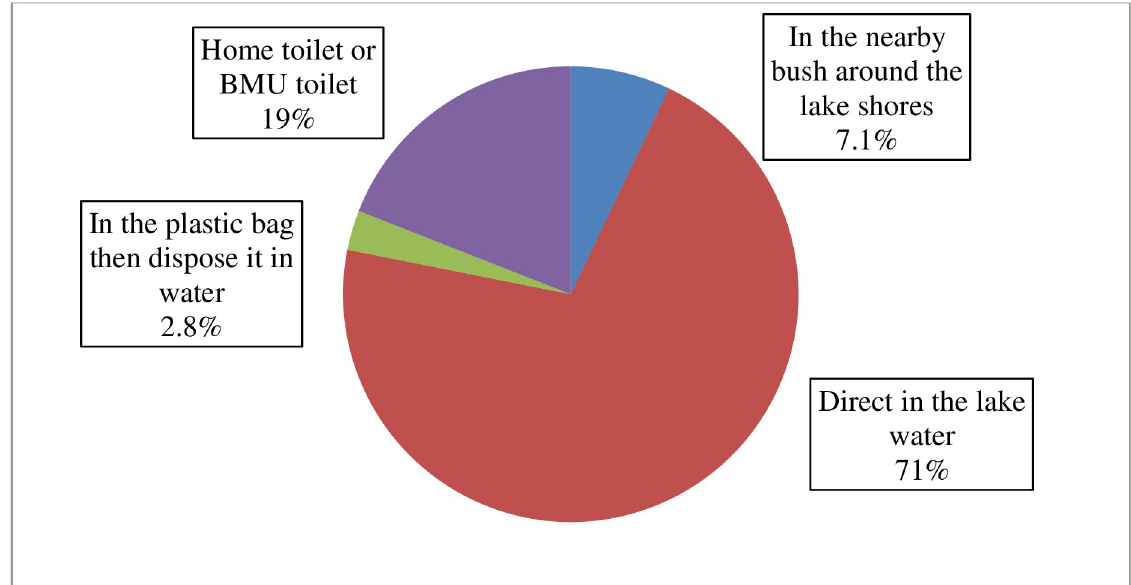
Fig 1. The place mostly used for defecation during fishing